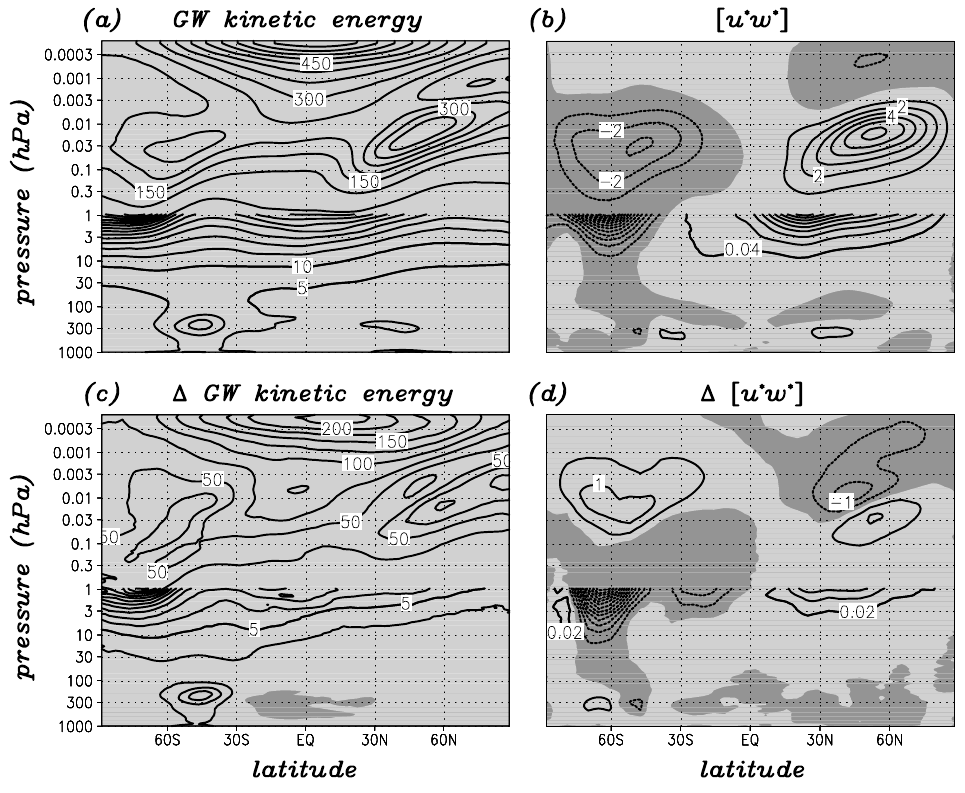
Fig. 7. GW kinetic energies and zonal-mean momentum fluxes in the climatological zonal mean. (a) Kinetic energy associated with the divergent, transient part of the resolved flow in the “July 2002” run (contour interval 50m 2 s − 2 above 1hPa and 5m 2 s − 2 below). (b) Vertical momentum flux due to transient waves in the “July 2002” run (contour interval 1m 2 s − 2 above 1hPa and 0.04m 2 s − 2 below). (c) , (d) Same as (a), (b), but for the differences in the “July 2002” experiment from the “normal July” simulation (contour intervals are 25 and 0.5m 2 s − 2 above 1hPa, or 2.5 and 0.02m 2 s − 2 below). Zero contours are not drawn. Positive and negative values are indicated by light and dark